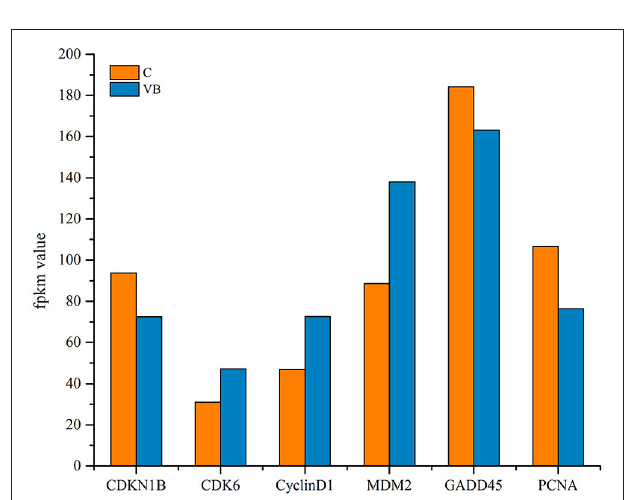
FIGURE 12 | Expression level of genes related to regulation of cell